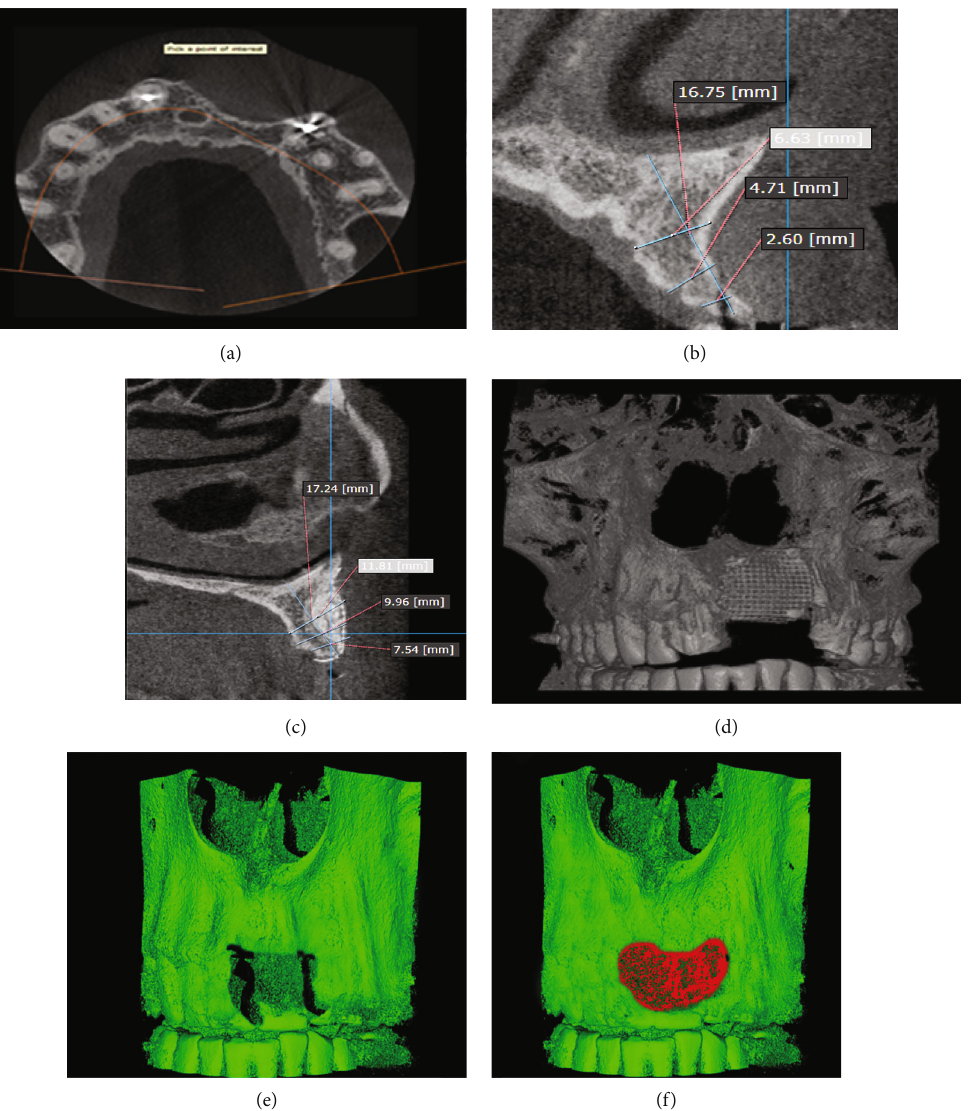
Figure 2: (a) Initial image showing sagittal section. (b) Initial image and linear data with measurements. (c) Final image and linear data with measurements. (d) Panoramic view with the adaptive mesh. (e) Initial volumetric image. (f) Volumetric image after